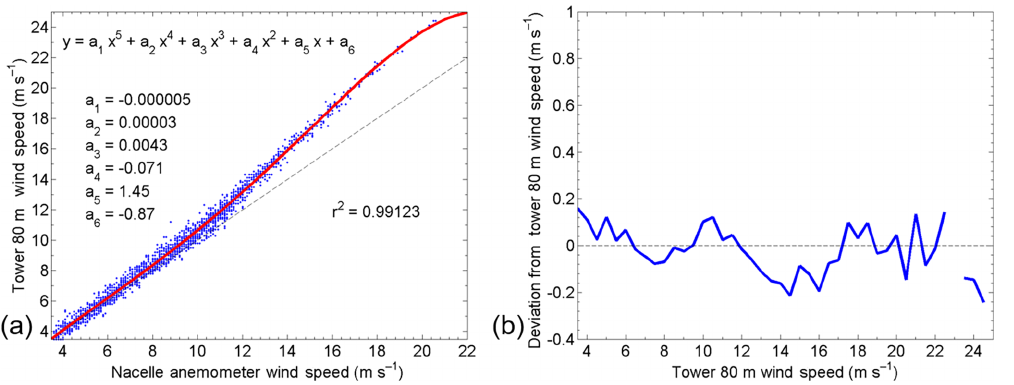
Figure 2. Comparison of upwind wind speeds with nacelle anemometer wind speeds: (a) scatter is the upwind tower 80m wind speed versus nacelle wind speed. The red line is the fifth-order polynomial fit and empirical transfer function between the tower 80m observations and the nacelle-mounted anemometer observations. The dashed line is 1 : 1. (b) Average deviation in fifth-order polynomial NTF-corrected nacelle-mounted anemometer wind speed from tower 80m wind speed versus tower 80m wind speed. The dashed line indicates a 0ms − 1 change. The figure includes data filtered for the tower 80m wind speeds between 3.5 and 25.0ms − 1 , 87m wind directions between 235 and 315 ◦ , and for normal turbine operation. Table 2. Defined stability and turbulence